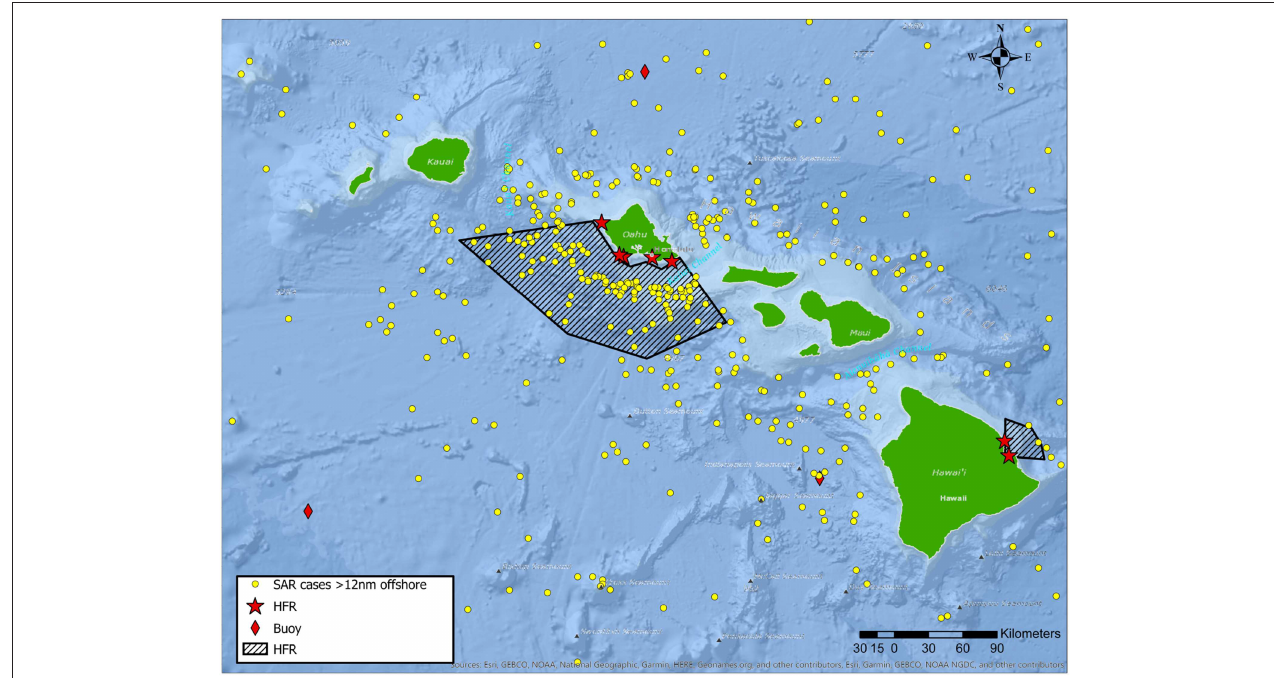
FIGURE 1 | Search and Rescue cases (yellow dots) in the Hawaiian Island region from 2002 through 2018. Only offshore cases ( > 12 nm from land) are shown. Red stars indicate the locations of High Frequency Radars, red diamonds are the locations of moored surface buoys. The black hatched boxes represents the spatial coverage of the HF Radars.